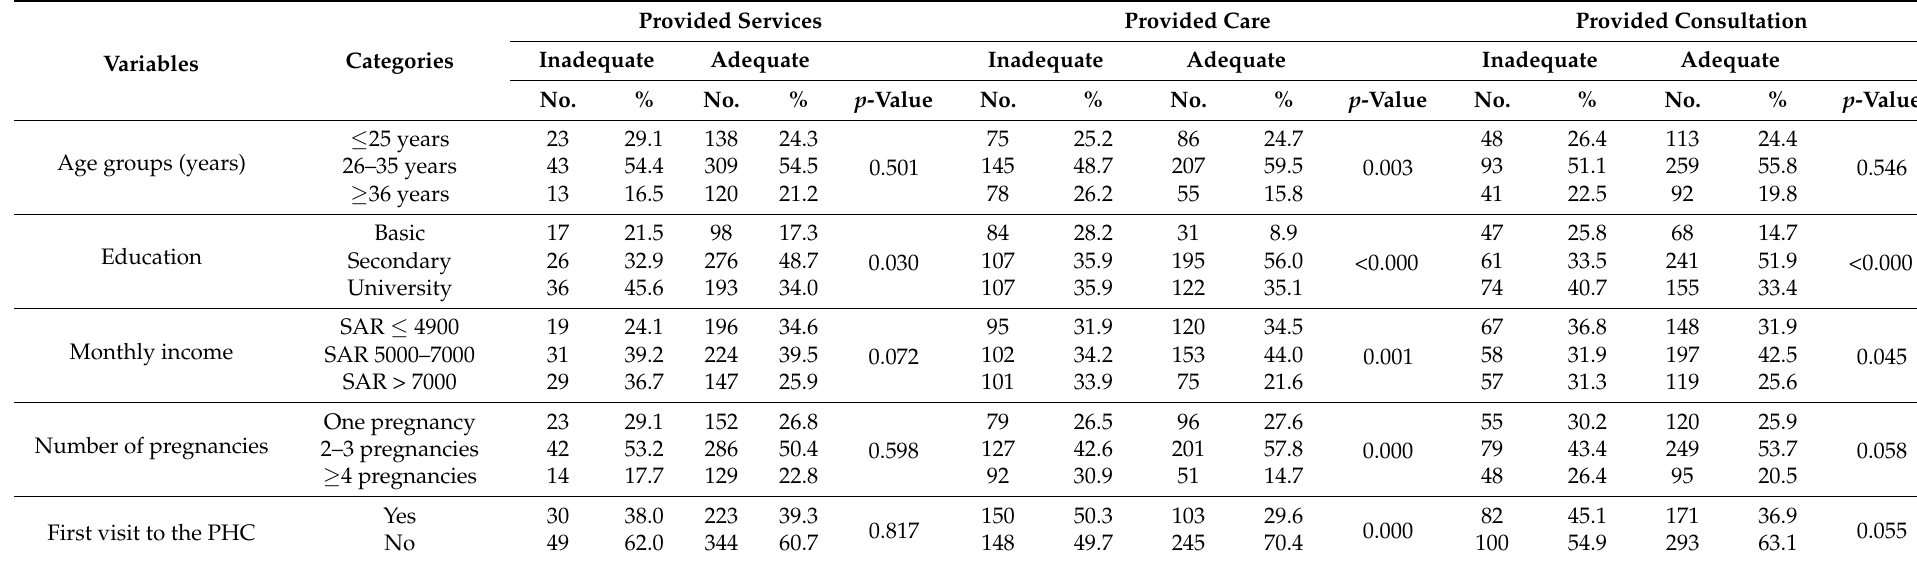
Table 2. Level of satisfaction with provided services, provided care, and provided